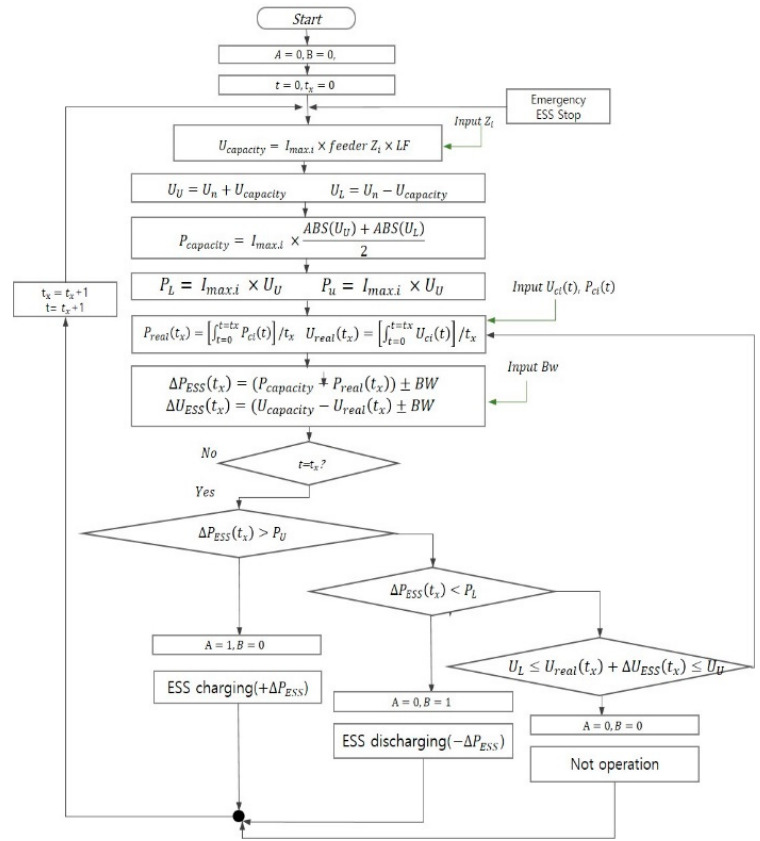
Figure 6. Stabilization strategy of hosting capacity by the ESS control.